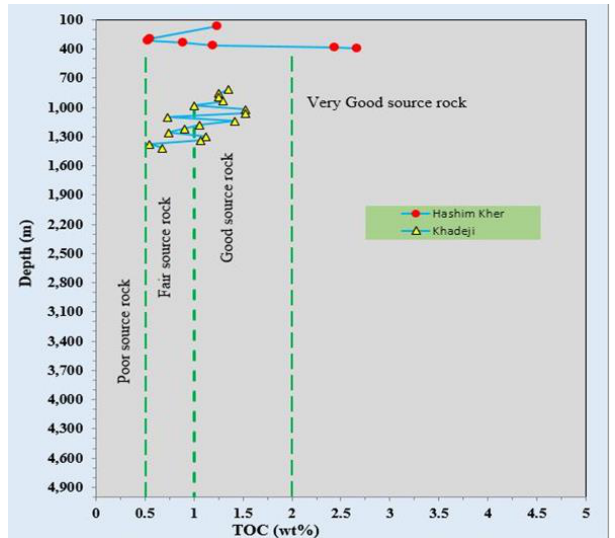
Figure 4: Showing cross plot relation between TOC and depth of the Laki Figure 3: Showing cross plot relation between TOC and depth of the Laki shales (diagram boundaries are after Tissot and Welte, 1984; Peters and shales (diagram boundaries are after Tissot and Welte, 1984; Peters and Cassa, Cassa, 1994).